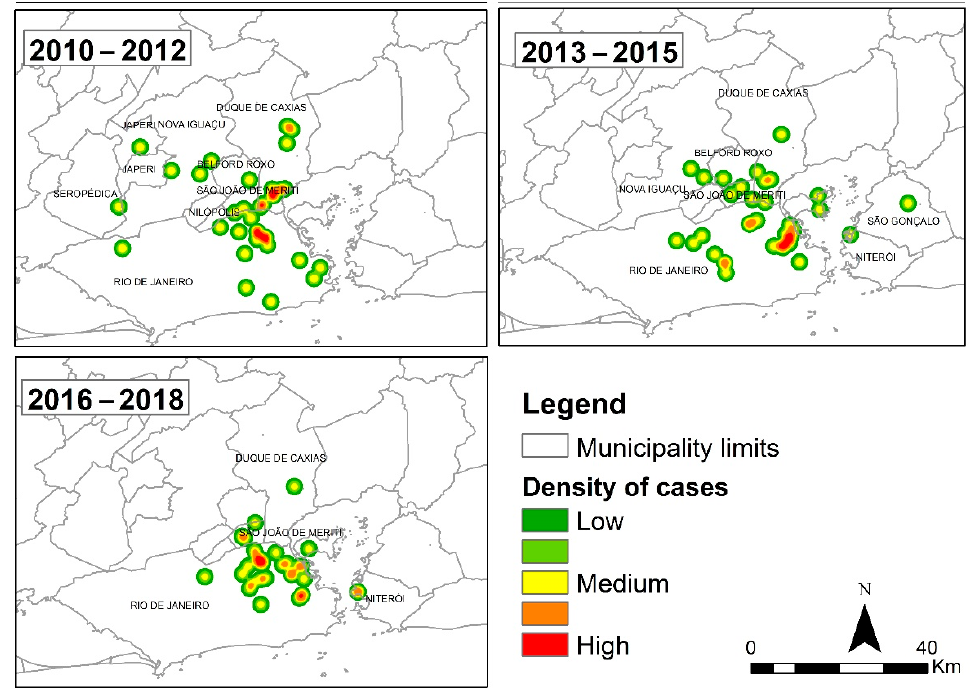
Figure 3. Kernel maps of the 249 canine sporotrichosis cases in the state of Rio de Janeiro, Brazil, over the periods studied.